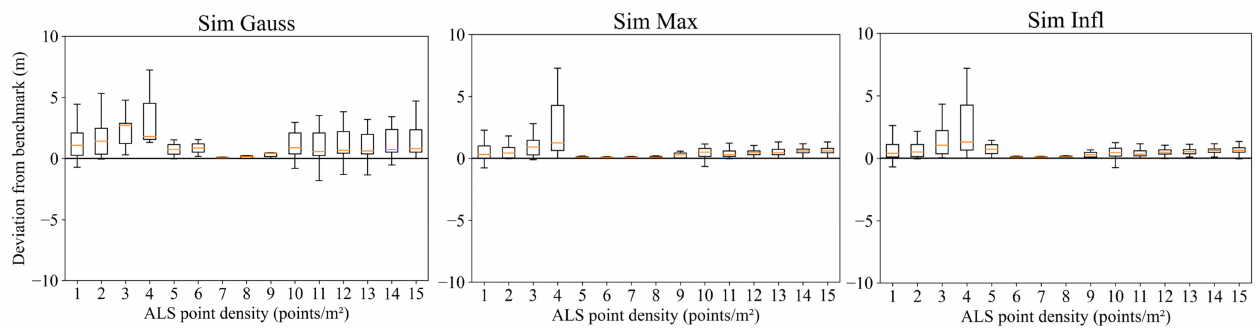
Figure 3. Deviation from true RH50 for the simulator’s Gaussian algorithm ( left ), Maximum al- gorithm ( centre ), and Inflection algorithm ( right ). Only observations with a terrain slope below 5 degrees were considered for this figure. Note that the density categories between 3 and 9 points/m 2 have low (<30) numbers of samples. Positive values indicate an overestimation of RH50.